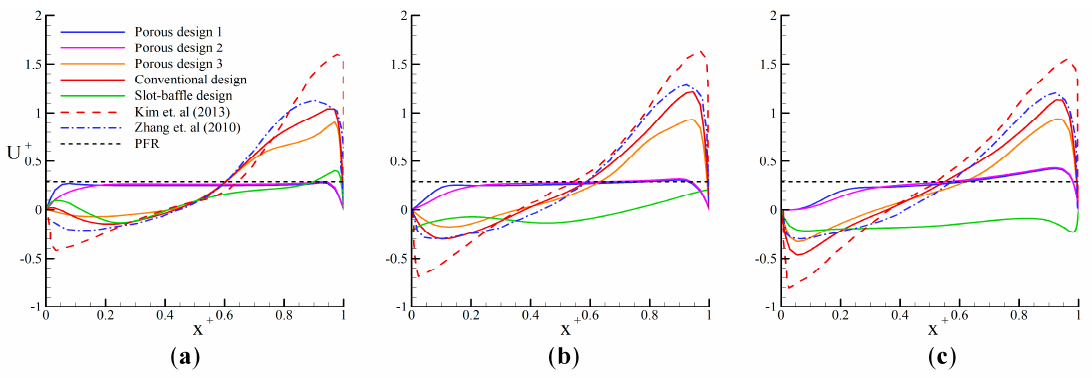
Figure 4. Variation of the vertical velocity component over the chamber width at different elevations ( a ) y/H = 0.27; ( b ) y/H = 0.5; and, ( c ) y/H = 0.72 [8,16].